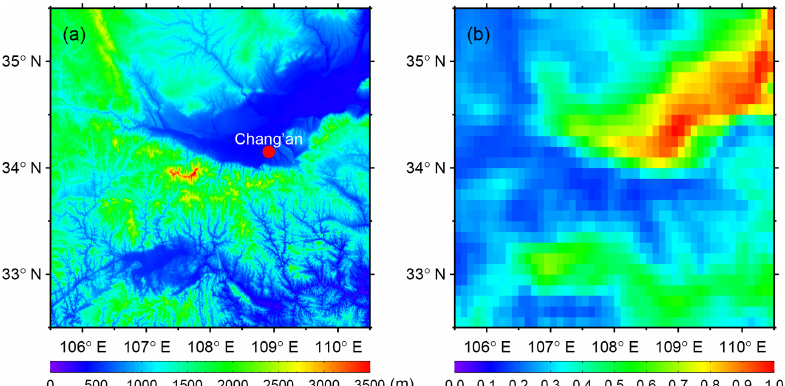
Figure 1. (a) A topographic map of the Guanzhong Plain and (b) the spatial distribution of AOD over the region shown in (a) . The red solid dot in (a) shows the location of the Qinling experimental site in Chang’an near